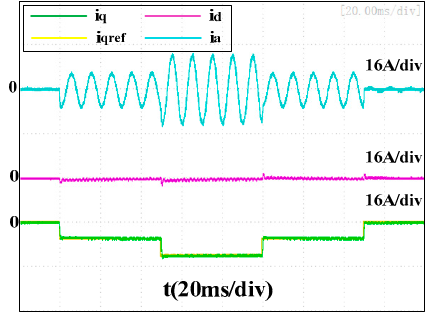
Figure 15. d-q axis current waveform of the conventional current controller with feedback decoupling at 6000 rpm with Kp = 1000 π Ls.